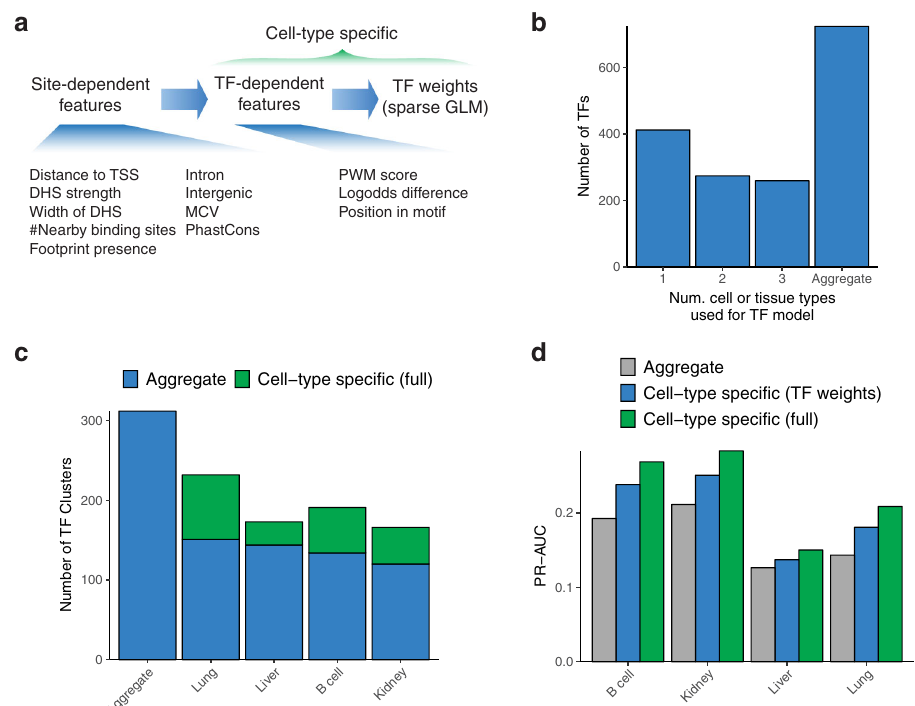
Fig. 6 Cell-type-speci fi c prediction of variation affecting TF occupancy. a . CATO2 strategy for cell-type-speci fi c scoring of regulatory variation. b . The number of mouse cell types used for each TF model; all TF models included human data. c . The number of unique TF clusters with non-zero coef fi cients in aggregate and cell-type-speci fi c CATO2 scores. TFs shared with the aggregate model are highlighted in blue. d The area under precision-recall curves (full curves are shown in Supplementary Fig. 7) showing performance to predict imbalanced polymorphism on SNVs tested for imbalance in individual cell